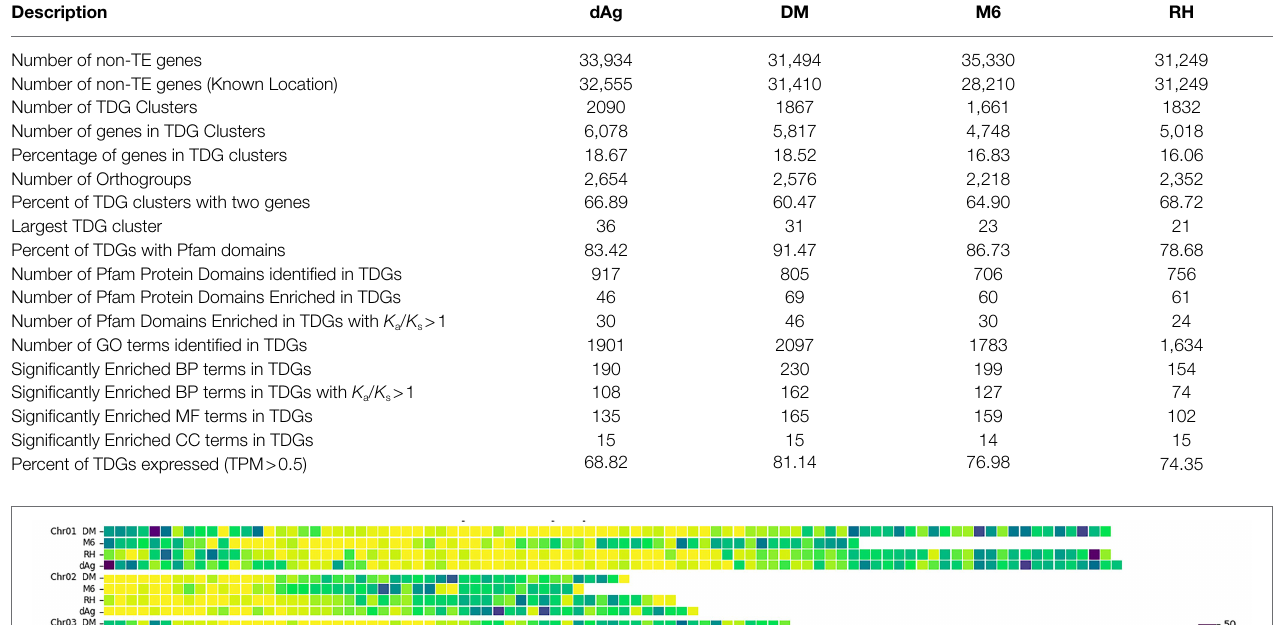
TABLE 2 | Summary of identified putative tandemly duplicated gene clusters in potato genomes.